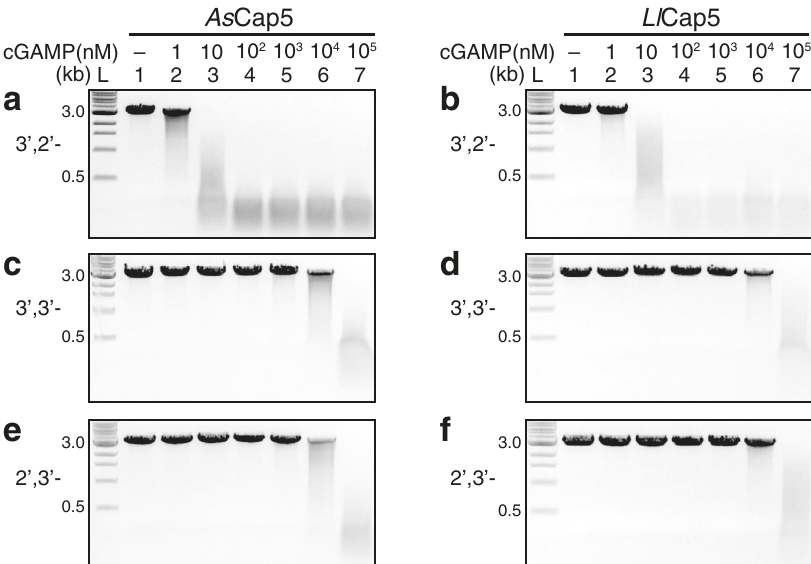
Fig. 2 In vitro reconstitution of the enzymatic activity of Cap5. DNA degradations were carried out by As Cap5 and Ll Cap5 in the presence of increasing concentrations of second messengers (10-fold increase with each step). Three different cGAMP were tested to activate Cap5 for DNA degradation. They are 3 ′ ,2 ′ -cGAMP ( a , b ), 3 ′ ,3 ′ -cGAMP ( c , d ), and 2 ′ ,3 ′ -cGAMP ( e , f ). L, DNA ladder marked with the molecular weight in kilo-base pair (kb). Results are representative of three independent experiments. Source data are provided as a Source Data fi